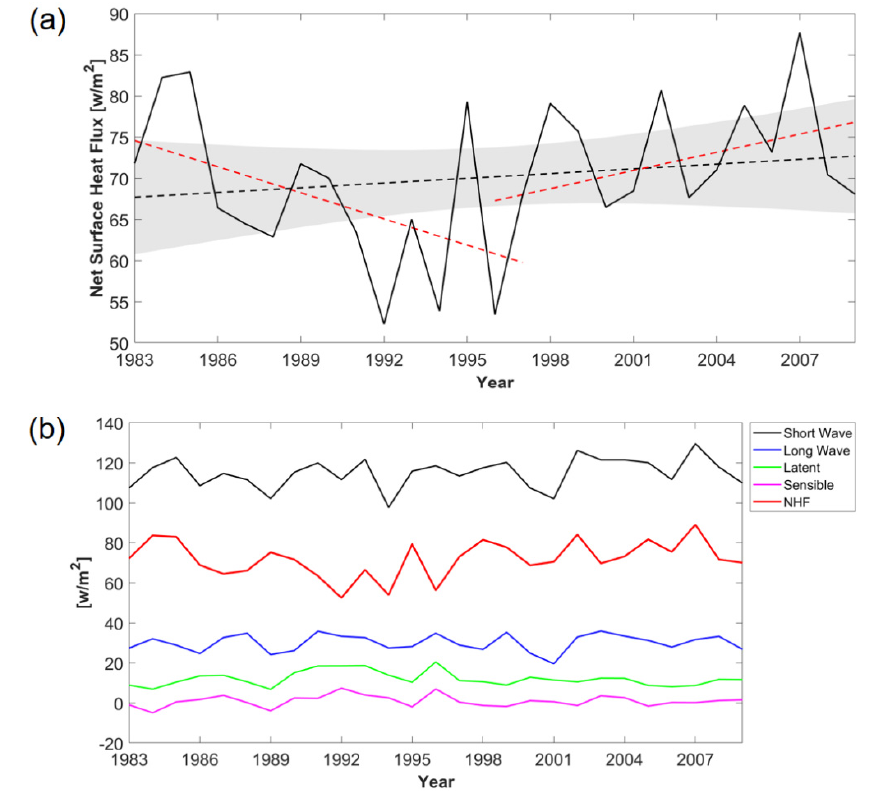
Figure 6. ( a ) Time series of net surface heat flux (NSHF) in the Chukchi Sea during summer from 1983 to 2009. The dash lines are trends of the whole (black line), pre- and post-1997 (red lines) periods. The gray shading indicates the two-sided 95% confidence boundary. ( b ) Time series of NHF (red line), net short-wave radiation (black line), net long-wave radiation (blue line), latent heat flux (green line) and sensible heat flux (magenta line).